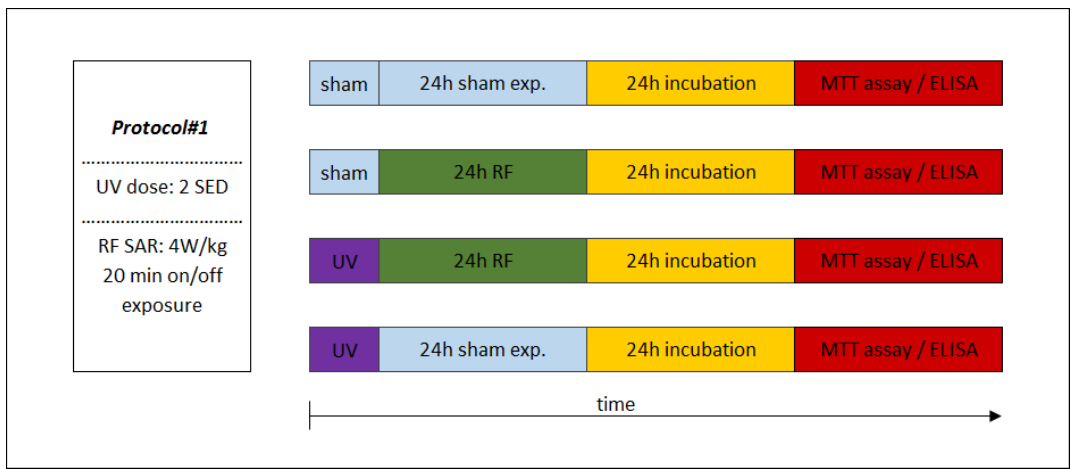
Figure 4. Experimental protocol of combined consecutive exposure for investigation of cooperative effects of exposure to RF and UV. Under Protocol#1, the skin tissues were first exposed to 2 standard erythemal dose (SED) UV and then 24 h 1950 MHz WCDMA (UMTS) modulated RF for 20 min on/off exposure with 4 W/kg SAR.